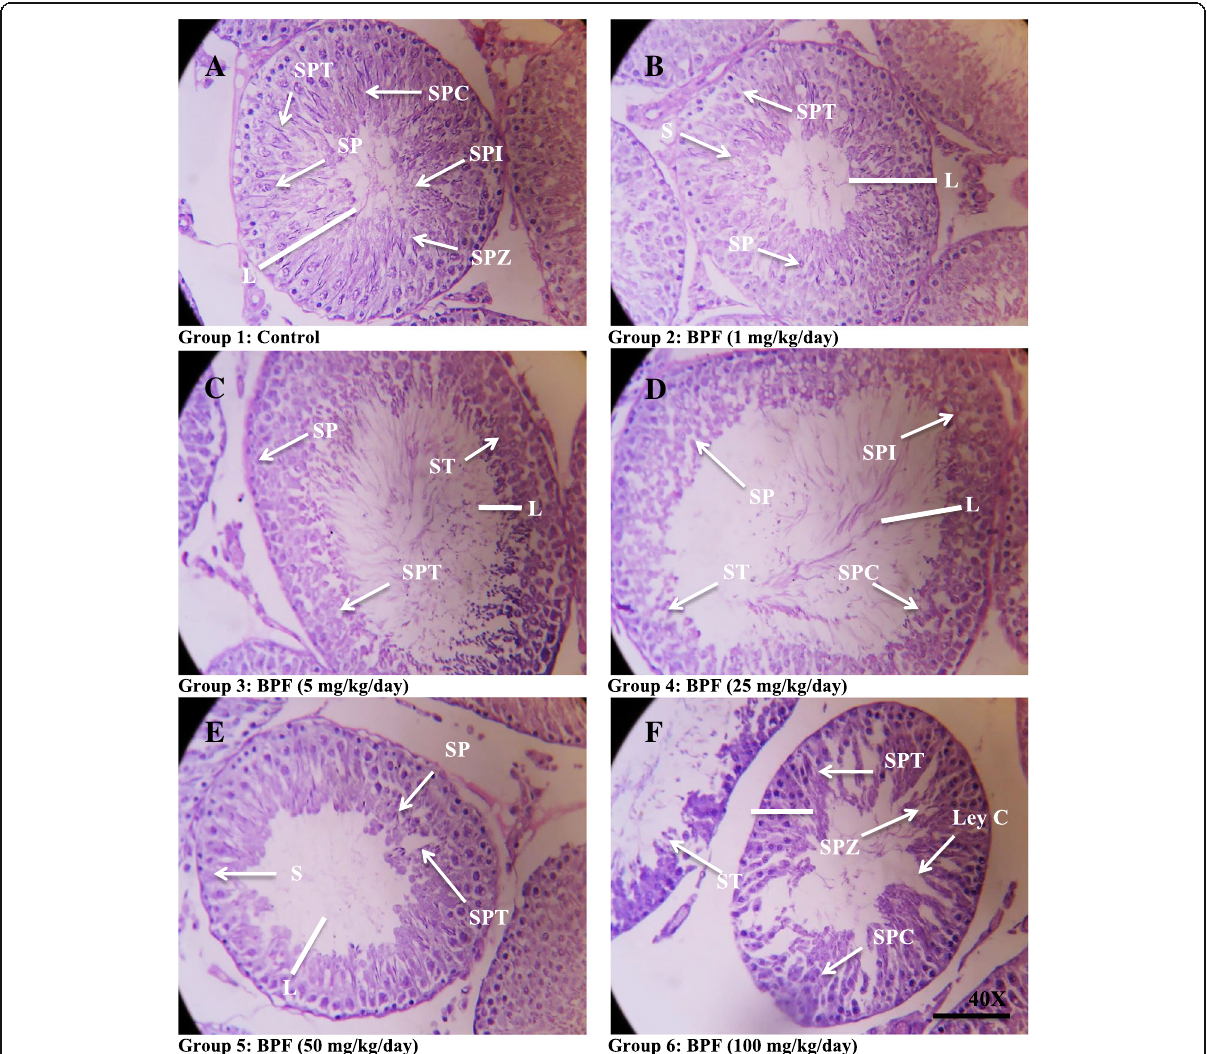
Fig. 1 Photomicrographs of rats testicular tissues of control and treated animals with different concentrations of BPF. The control ( a ) reveals normal germ cells: spermatogonia (SP), spermatocytes (SPC), spermatids (SPT), spermatozoa (SPZ). b – f Treated groups with BPF (1, 5, 25, 50, and100 mg/kg/day) showing changes in the testicular tissues seminiferous tubules with epithelium (Line without arrowhead), showing change in the testicular parenchyma, absence of sperm in lumen, seminiferous tubules with germ cells, Leydig cells (LeyC), absence of sperm in lumen of tubules and spermatids. Presenting ST, seminiferous tubules; SP, spermatogonia; SPC, spermatocytes; SPT, spermatids; SPZ, spermatozoa; IT, interstitial tissue; LeyC, Leydig cell (White arrow). H&E (×